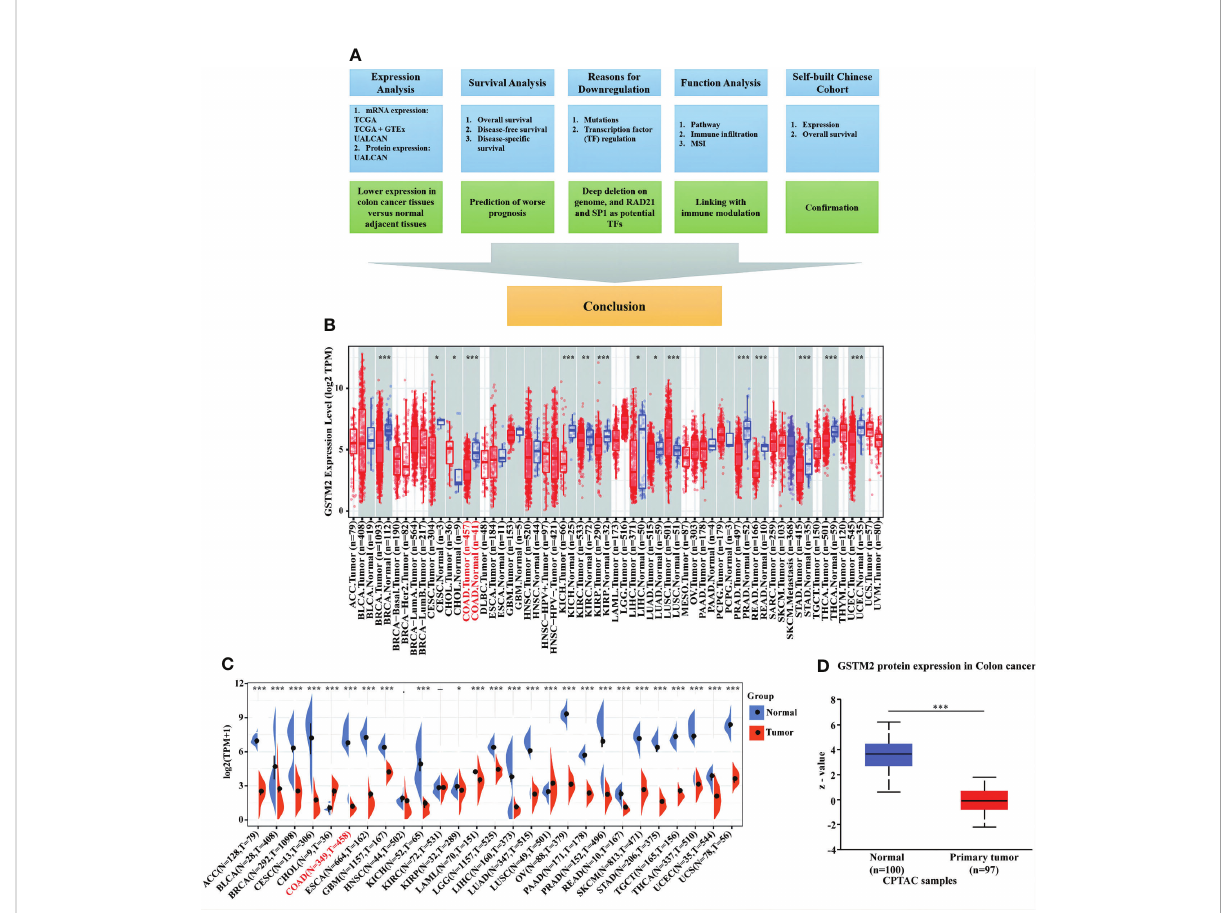
FIGURE 1 GSTM2 is Decreasingly Expressed in Colon Cancer Tissues versus Normal Tissues. (A) Flow chart of this research. GSTM2 mRNA expression in different types of cancer was studied using (B) the TIMER database, and (C) the TCGA database and GTEx database. The protein expression of GSTM2 in colon cancer tissues versus normal tissues was investigated using (D) the UALCAN database. *p < 0.05, **p < 0.01, and ***p <